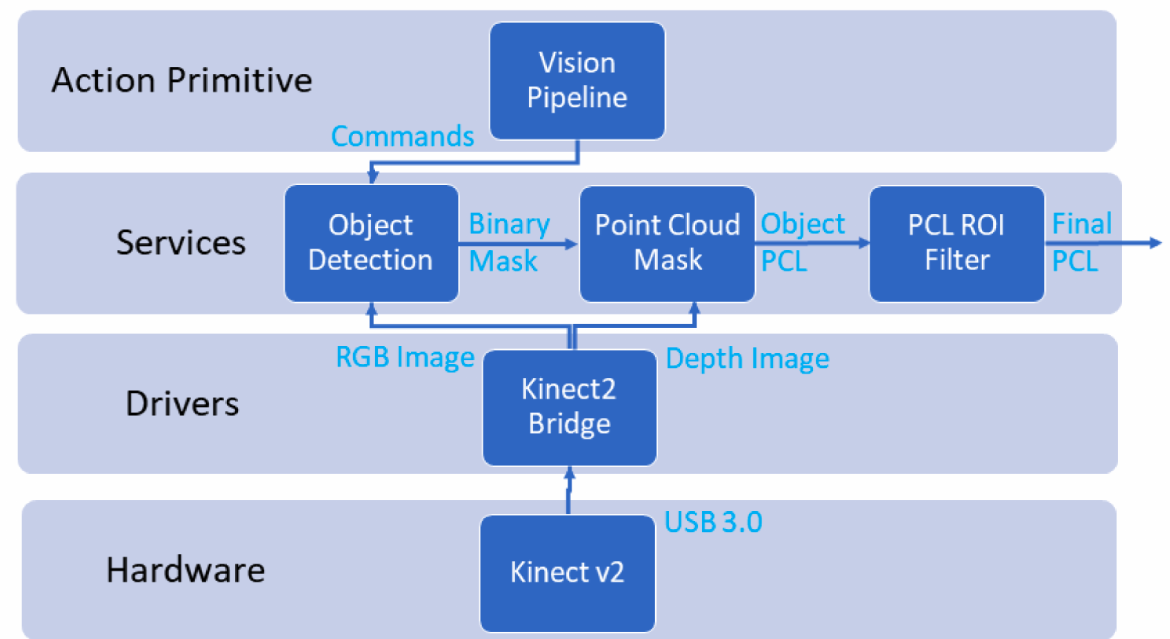
Figure 4. Vision system